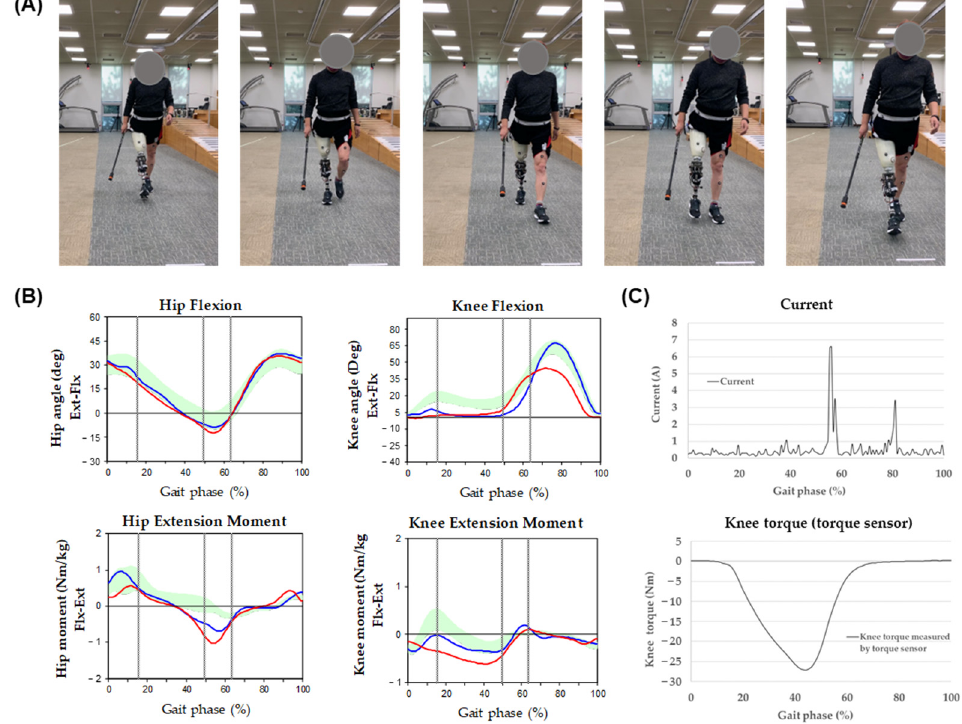
Figure 13. Analysis of gait in active mode, ( A ) Snapshots of amputee’s frontal view during walking, ( B ) The knee and hip joint kinematics of our prosthesis during level ground walking using a three- dimensional motion analysis system, ( C ) Quantitative plots of current and knee torque mounted on the prosthesis during level ground walking.